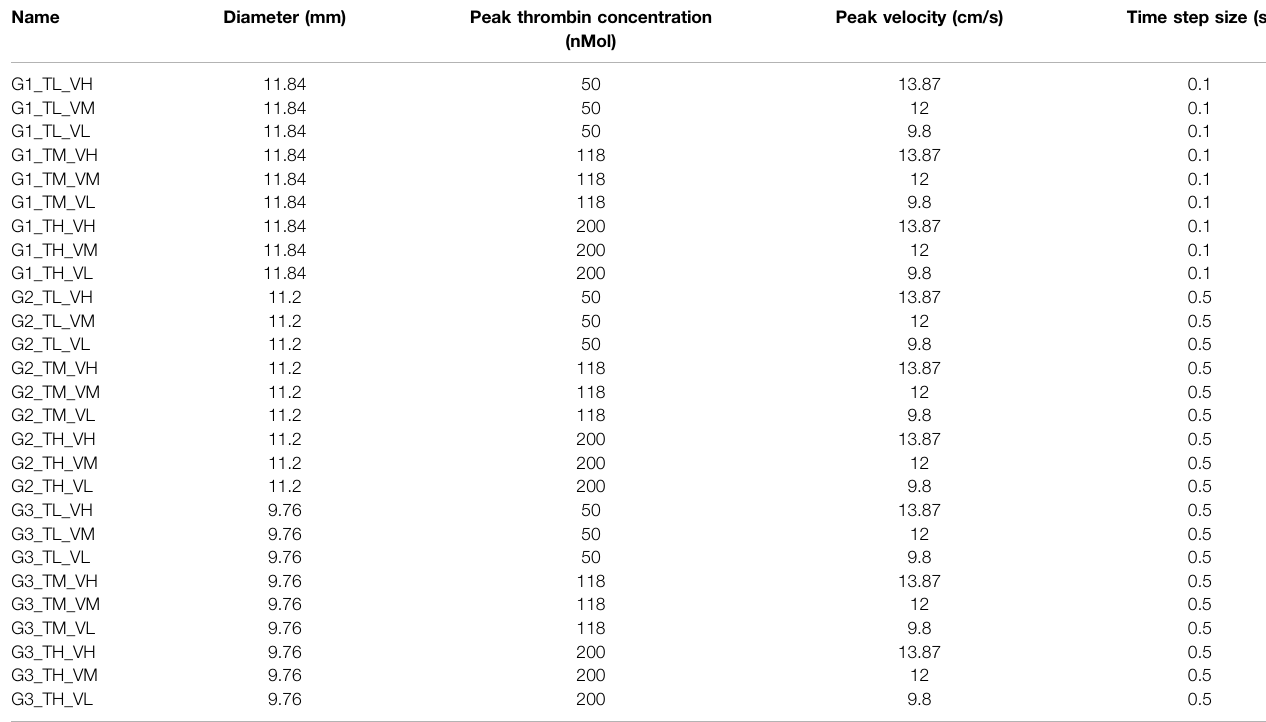
TABLE2| Simulationnamesandtheparametersusedforeachsimulationcarriedoutinthisstudy(2dsimulation).WiththenotationG(1,2,3)_T(L,M,H)_V(L,M,H)indicating the geometry(G) being 1, 2, or 3, thrombin concentration (T) and velocity (V) being low, middle, or high. Name